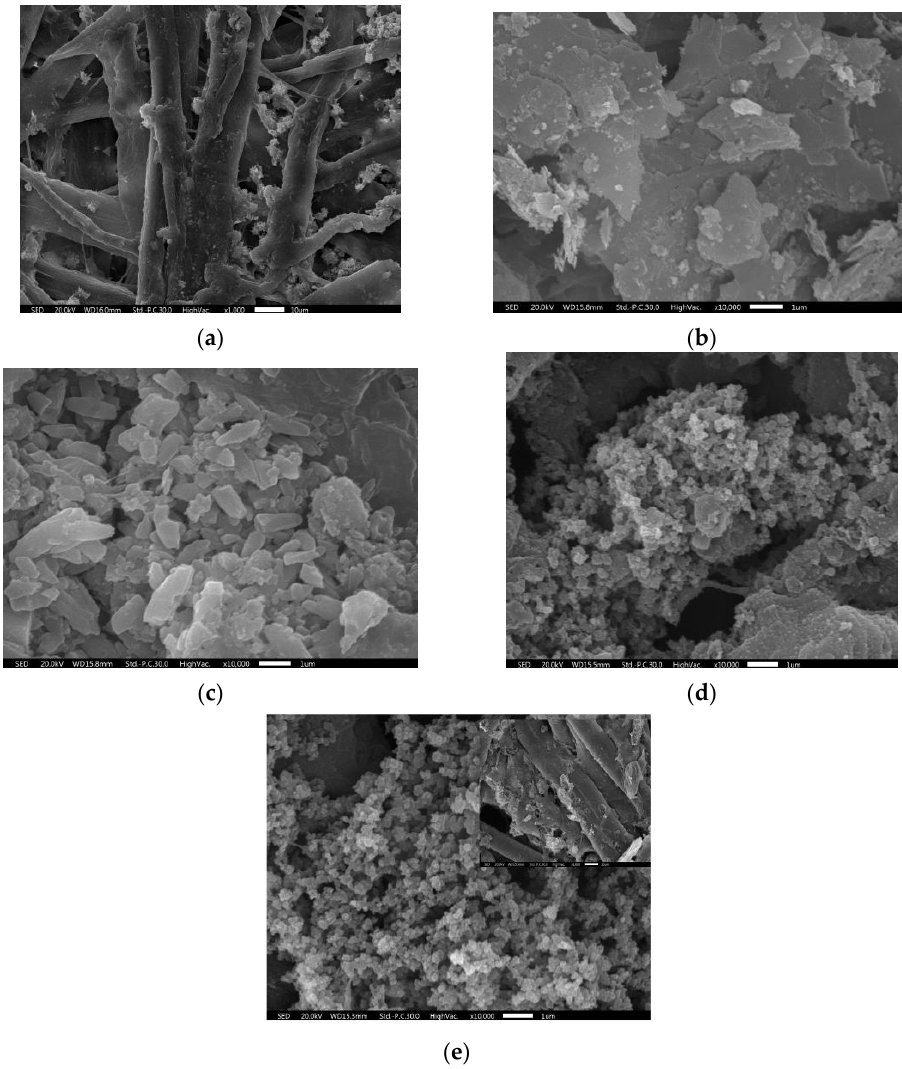
Figure 2. SEM images of ( a ) blank paper; ( b ) G-paper; ( c ) EG-paper; ( d ) PPy-G-paper; and ( e ) PPy-EG-paper.